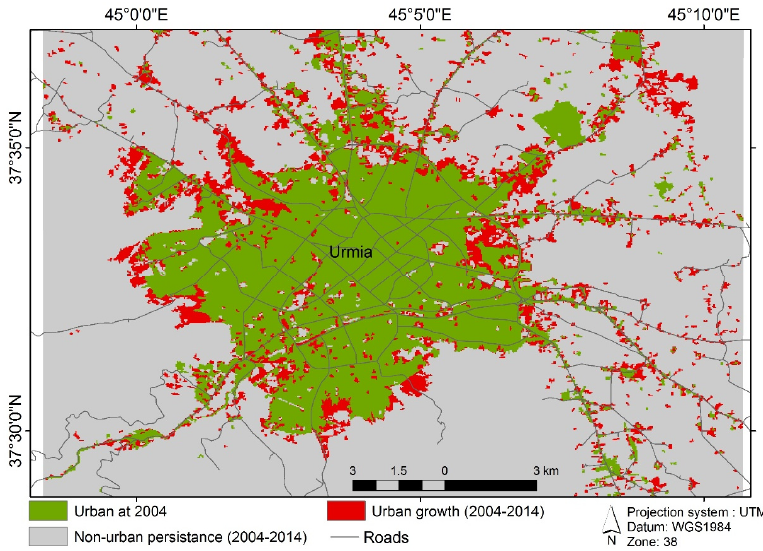
Figure 4. Urban growth in Urmia from 2004 to 2014.